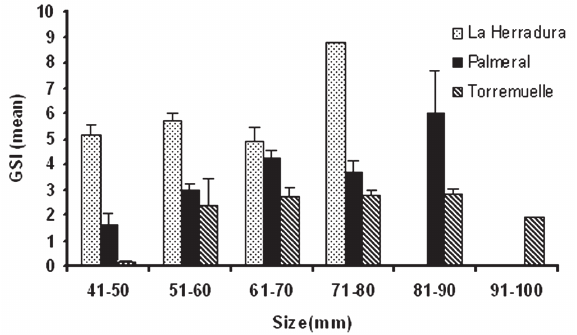
Fig . 3 . – Gonadosomatic Index for each size (diameter) class at the three sampling localities.